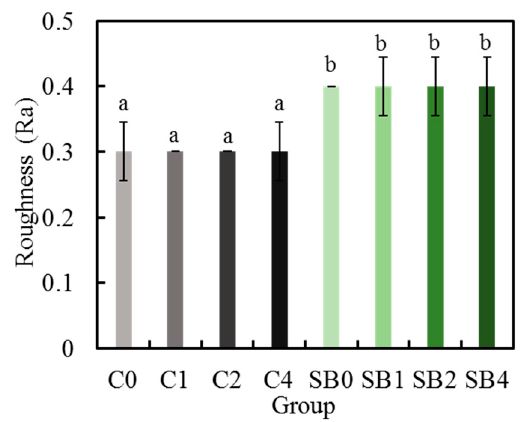
Figure 4. The surface roughness values of the zirconia before and after plasma treatment. The different letters “a” and “b” indicate significant differences (p < 0.05) (n = 5).